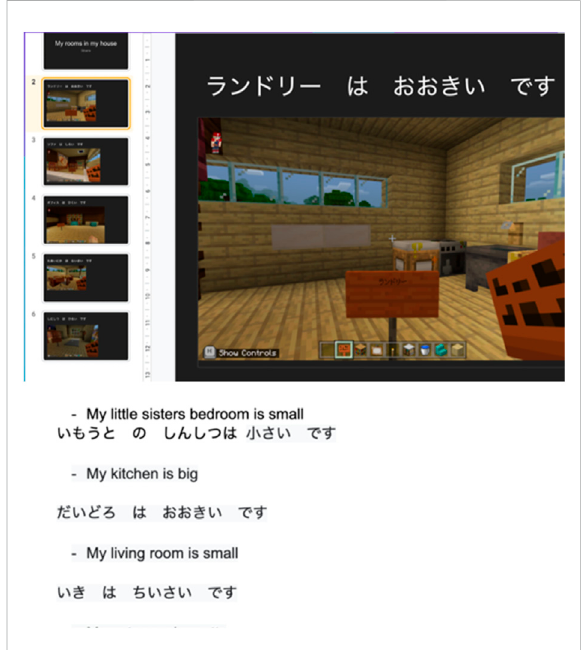
FIGURE 6 The PowerPoint slide containing the images and transcript a student used to create their